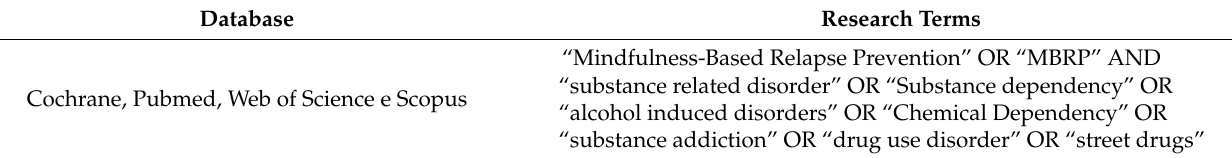
Table A1. Research terms used in databases.